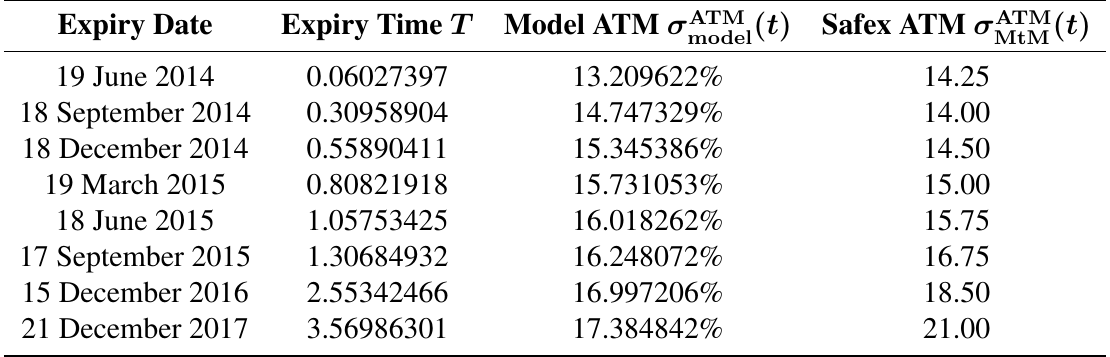
Table 3. Model and official Safex at-the-money (ATM) volatilities on 28 May